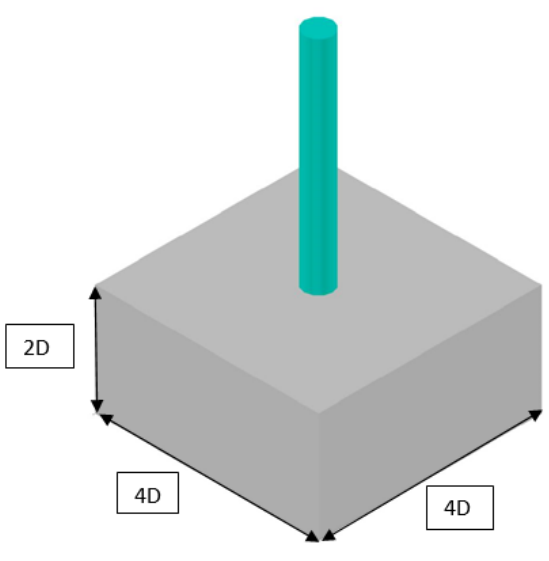
Figure 17: Virtual parallelogram represents the zone of significant influence during tunnel advancement.